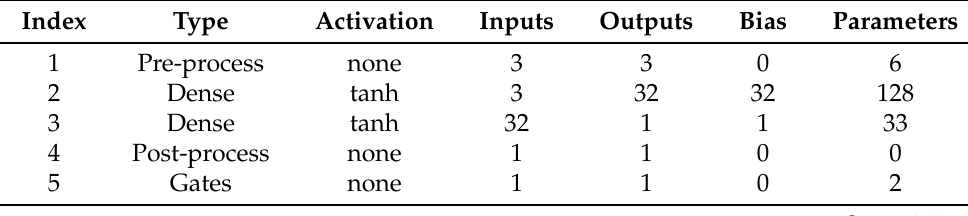
Table 1. ANN layout and parameters of the used